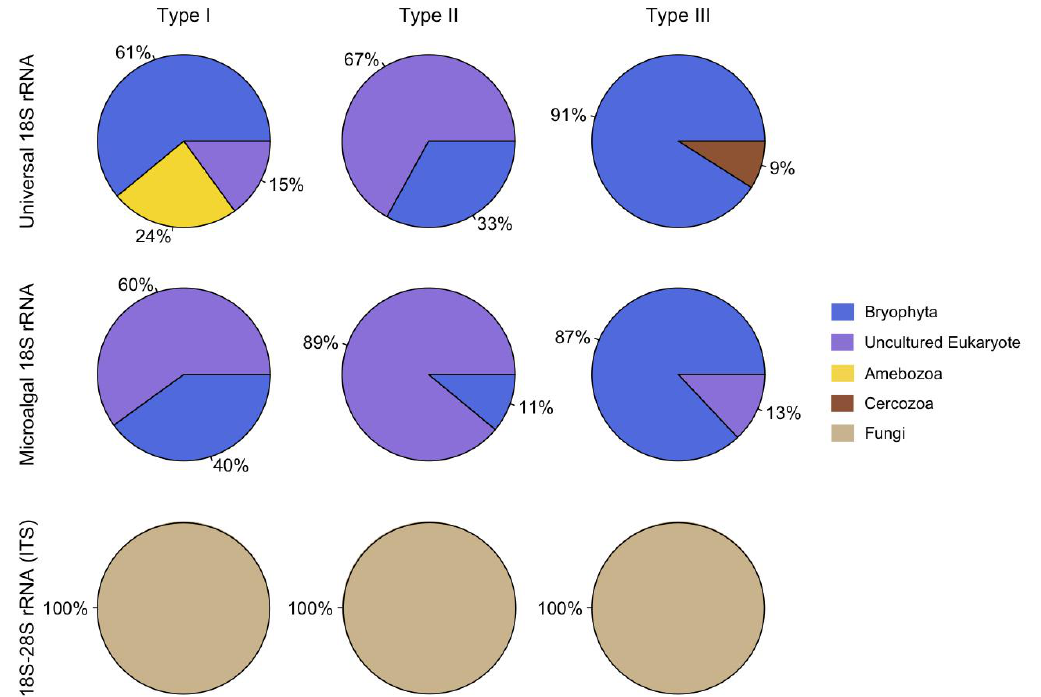
Figure 1. Relative distribution of phylotypes.